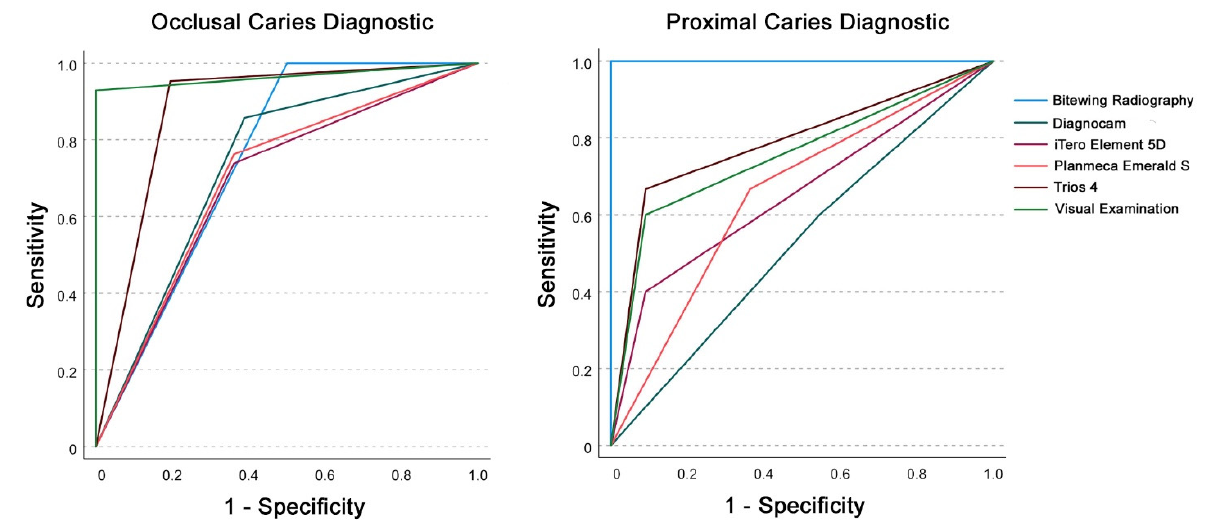
Figure 5. Receiver operating characteristic (ROC) curve analysis for occlusal ( left ) and proximal ( right ) caries diagnostic for the investigated diagnostic methods in primary teeth with threshold I (sound (0)) versus overall caries (pooled data of enamel (1) and dentin caries (2)).